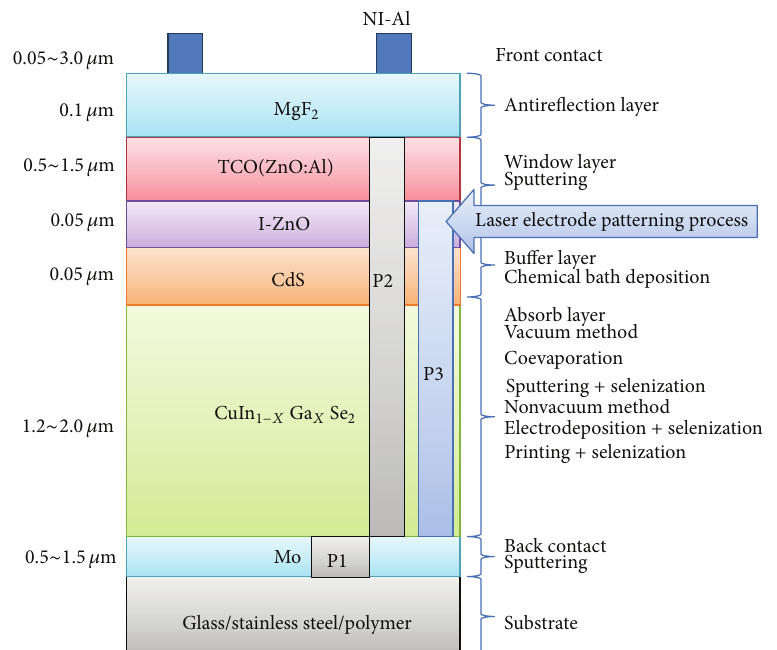
Figure 3: Diagram of the laser solar cell film [16].